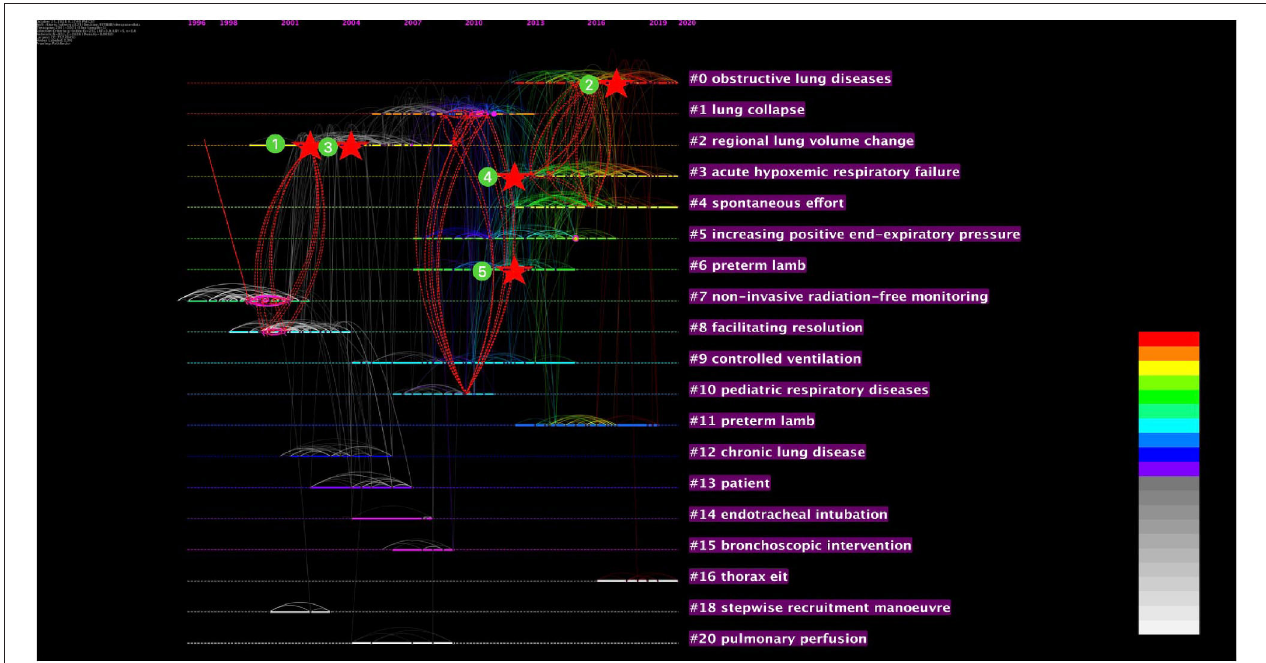
FIGURE 7 | The co-cited reference structural variation analysis (SVA) on EIT lung monitoring research from 2001 to May 29, 2021 (Modularity Q = 0.76; Weighted Mean Silhouette S = 0.87). The stars indicate citing articles, and the dashed lines indicate novel co-citation links. [ ‹ : Victorino et al. ( 11); › : Frerichs et al. (12); fi : Frerichs et al. ( 13); fl : Adler et al. (25); 5 (cid:13) : Leonhardt et al.